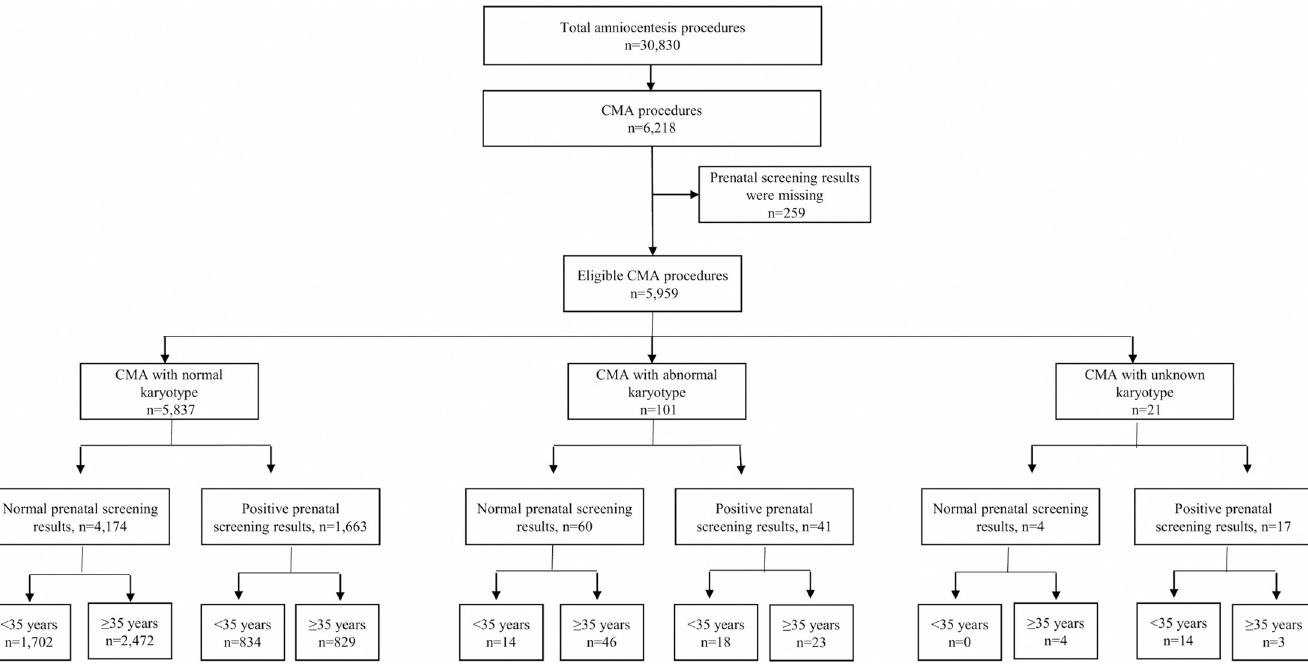
PLOS ONE | https://doi.org/10.1371/journal.pone.0250734 April 26,